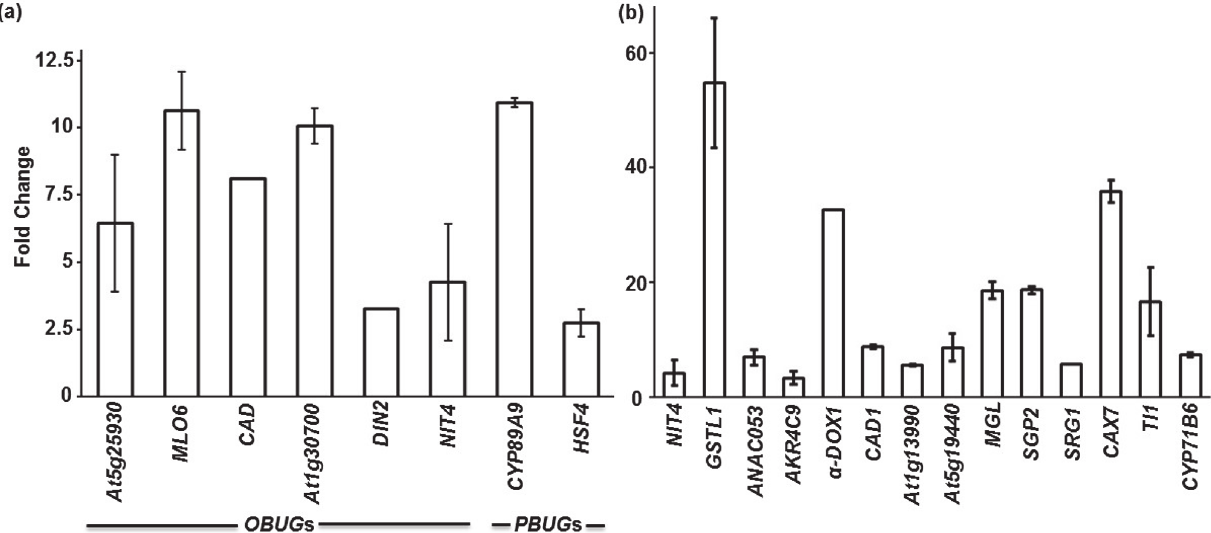
Fig 5. Expression of OBUG s/ PBUG s and abiotic stress-regulated genes in response to B . cinerea . Relative expression levels obtained through qRT-PCR for common OBUG s or PBUG and abiotic stress-upregulated genes (A); and OBUG s/ PBUG s and abiotic stress-upregulated genes (B) after infection with B . cinerea at 18 hpi. Expression of B . cinerea -inducible genes was quantitated relative to control conditions (no infection), and corrected for expression of the control gene ( β -actin). Error bars for qRT-PCR values are the standard deviations (n (cid:2) 3). In (a) and (b), data were obtained from Tables 4 and 5, respectively. hpi, hours post inoculation; At Actin2 , Arabidopsis Actin2 gene.